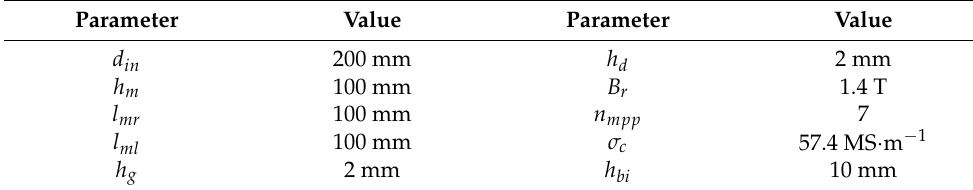
Table 3. Physical parameters of a design